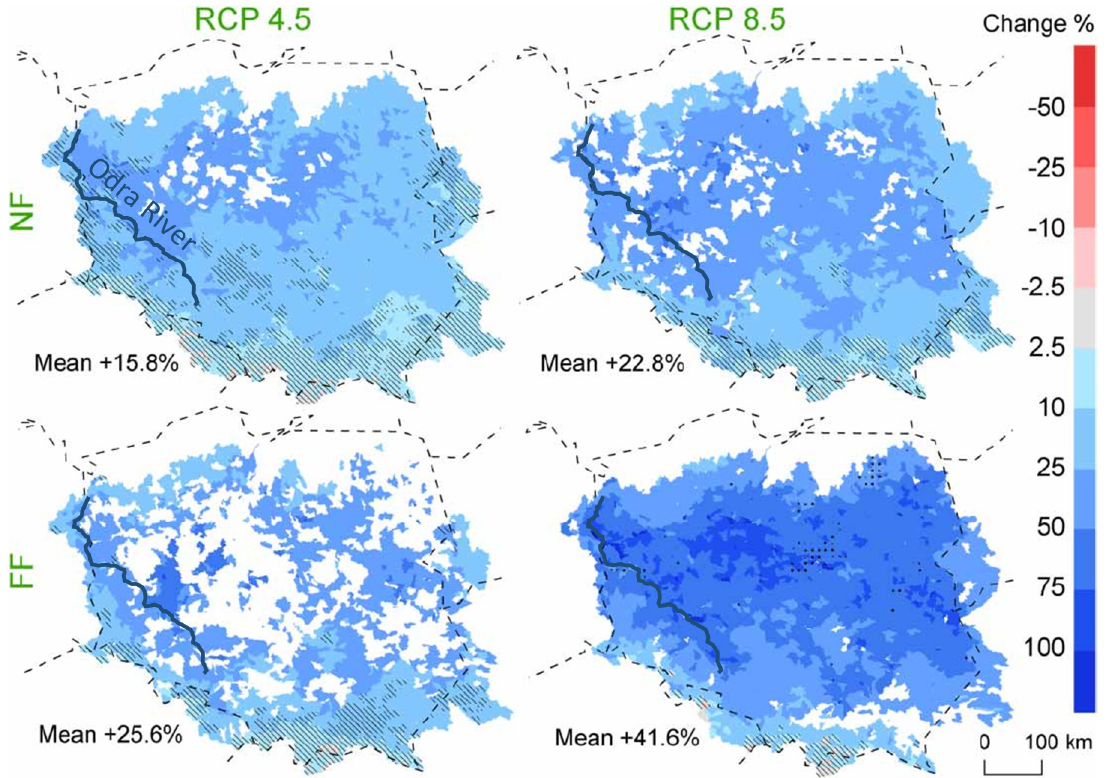
Figure 12. Changes in the multi-model ensemble means of annual runoff for the Vistula and Oder river basins, for the near future (NF) and far future (FF) (2021–2050 and 2071–2100, respectively) under Representative Concentration Pathway (RCP) 4.5 and 8.5 (adapted from [13]).